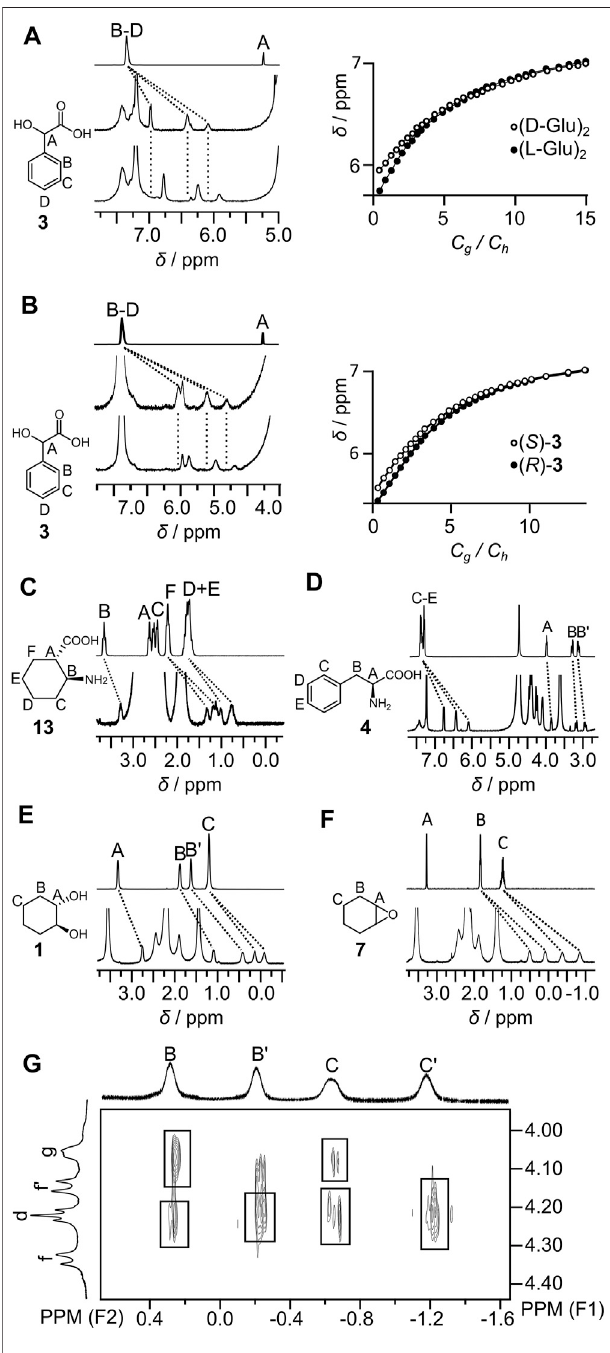
FIGURE 5 | Complexation properties of the capsules (partial 1 H NMR spectra and selected titration curves): (A) 3 (top) and ( S )- 3 with (L- GluR ) 2 (middle) and with (D- GluR ) 2 (bottom); (B) 3 (top) and ( S )- 3 with (L- ArgR ) 2 (middle) and ( R )- 3 (L- ArgR ) 2 (bottom); (C) (L- GluR ) 2 with (1 S , 2 R )- 13 ; (D) (L- GluR ) 2 with( S )- 4 ; (E) (L- GluR ) 2 with(1 S ,2 S )- 1 ; (F) (L- GluR ) 2 with 7 ; (G) partial ROESY spectrum of (L- GluR ) 2 with 7 (D 2 O, 600 MHz).